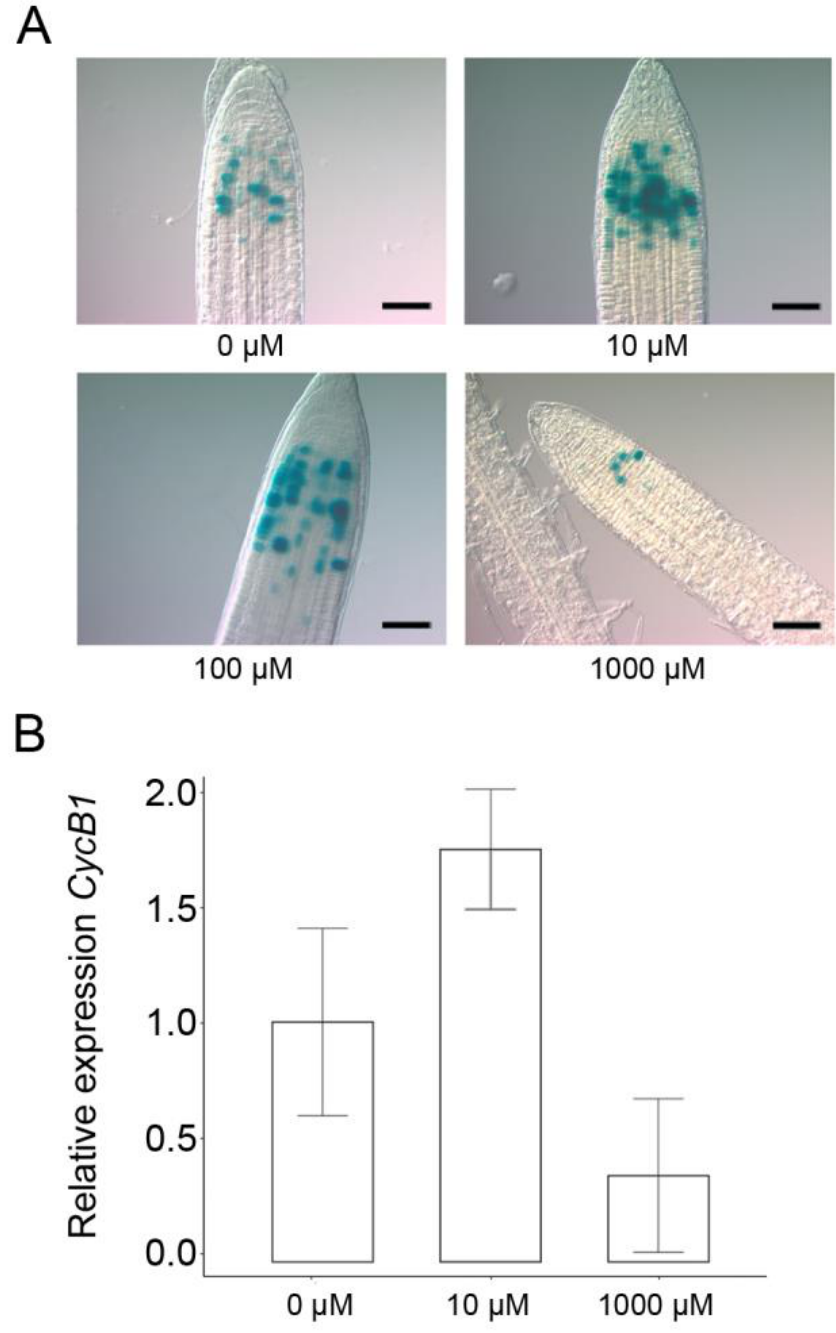
Figure 3. Effects of exogenous hydrogen peroxide on the meristem size of an Arabidopsis root. ( A ) Seven-day-old CYCB1 :GUS plantlets were treated with increasing concentrations of H 2 O 2 and roots were stained for GUS activity. At 10 and 100 µ M H 2 O 2 , the meristem area and the number of dividing cells were increased, whereas, at 1 mM H 2 O 2 , there was inhibition of cell division. H 2 O 2 concentrations above 10 mM were highly toxic to Arabidopsis plantlets, which hardly germinated and grew. Bars = 40 µ m. ( B ) RT-qPCR analysis of the expression of CYCB1;1 in wildtype roots. Transcript levels were normalized to 0 µ M H 2 O 2 and RCH1 . The expression of the root meristem-specific ROOT CLAVATA HOMOLOG 1 ( RCH1 ) was used as a reference gene to normalize CYCB1;1 expression over different meristem sizes. Cq-values are the average of three replicates of a representative biological replicate.